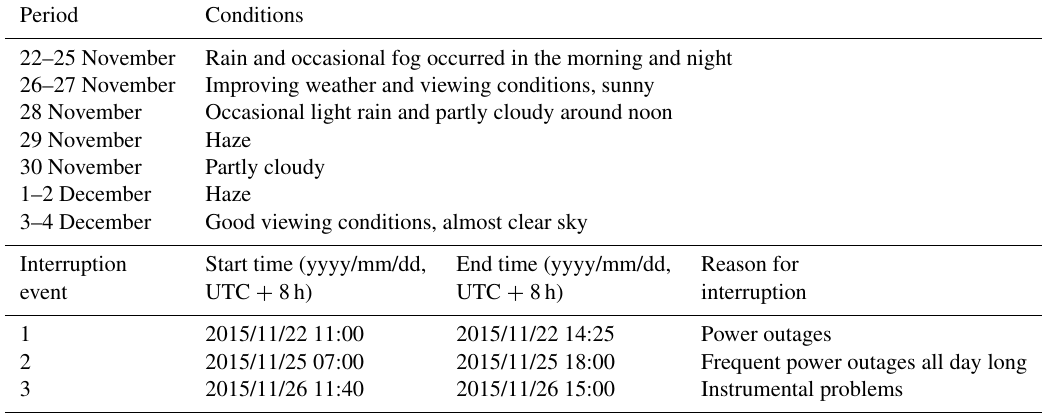
Table 1. Weather and viewing conditions during the Yangtze River campaign from 22 November to 4 December 2015. Interruption of the ship-based MAX-DOAS is also listed.